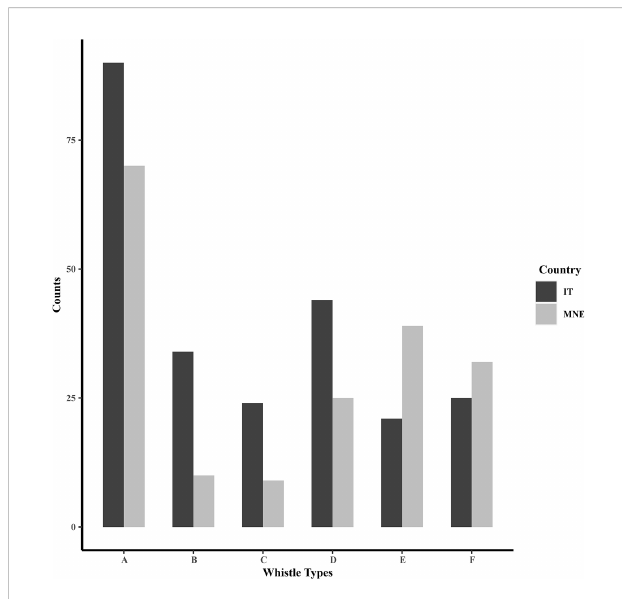
FIGURE 6 Counts of detected whistle types in the Taranto Gulf (IT) and Boka Bay